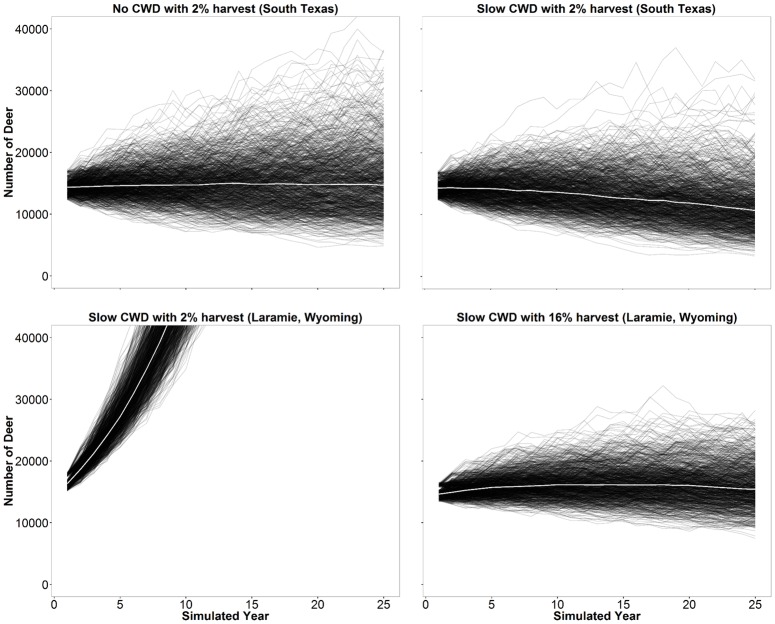
Plots of simulated white-tailed deer population trajectories.One thousand 25-year simulations were run to predict future populations without CWD and 2% harvest (top left) and with CWD and without harvest (top right) with fawn:doe ratios from South Texas, with CWD and 2% harvest (bottom left) and 16% harvest (bottom right) with fawn:doe ratios from Laramie, Wyoming. Slow CWD was modeled to increase 0.26% annually. White line indicates median of the 1,000 simulated projections.